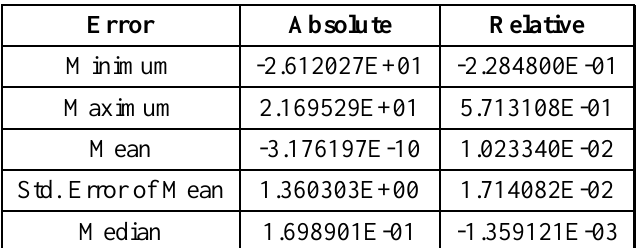
Table 7. Density estimation